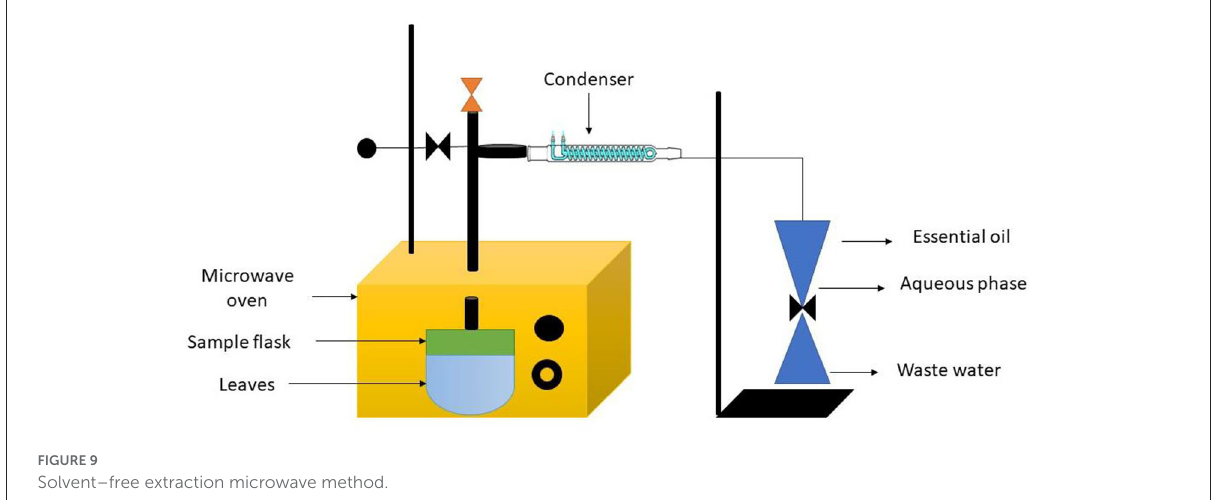
FIGURE9 Solvent–free extraction microwave method.